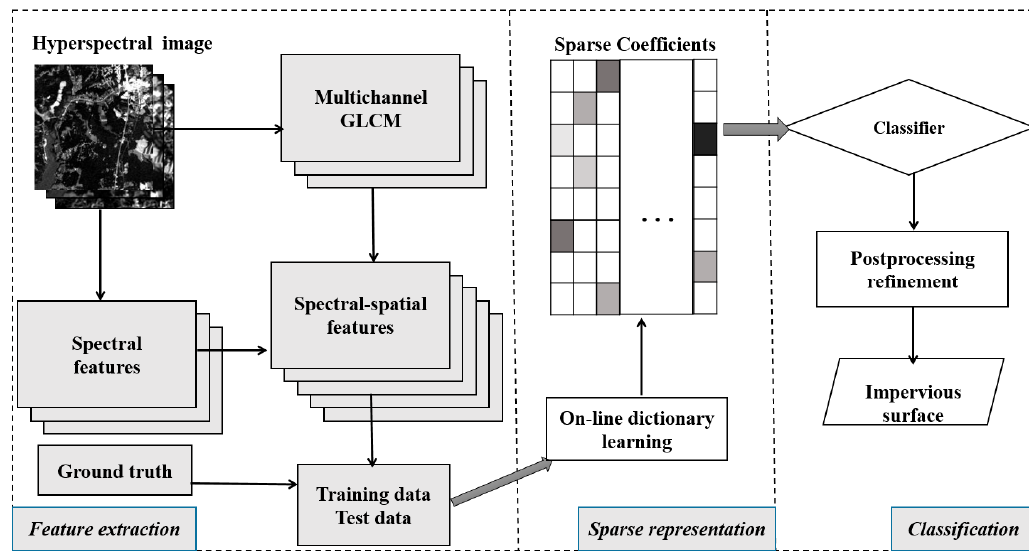
Figure 4. The flowchart of SS-SR and Post-processing based impervious surface estimation.